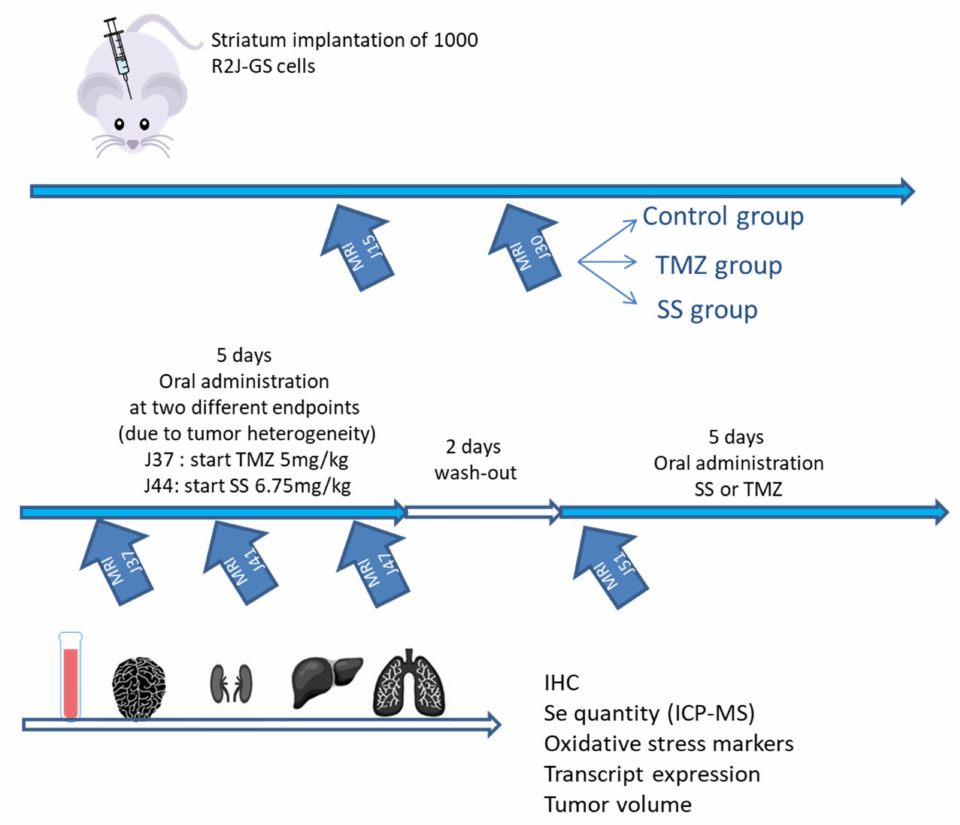
Figure 6. Experimental design to study the tumor regression in nude mice implanted with R2J-GS